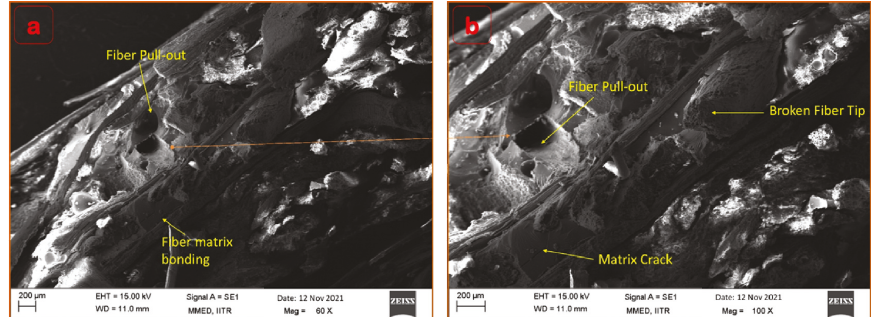
Figure 8: SEM micrograph of tensile fractured specimen with 30mm fiber length and 30 wt.% fiber content composites.